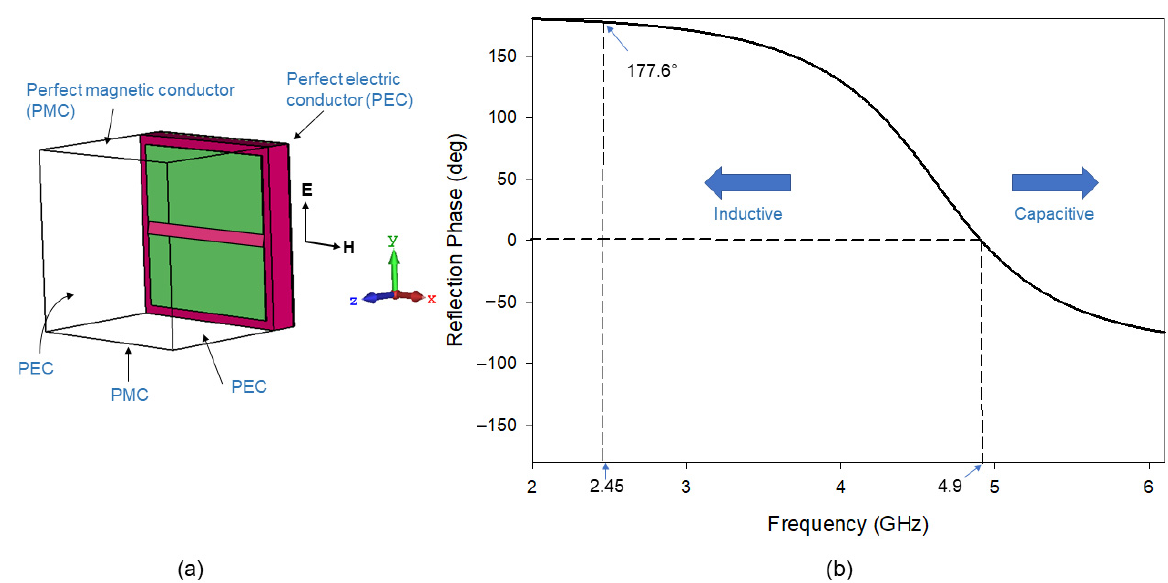
Figure 1. RIS unit cell simulation: ( a ) RIS unit cell model and ( b ) reflection phase diagram.